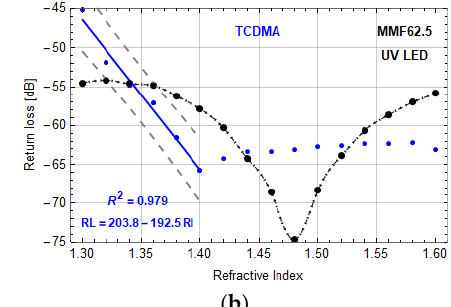
Figure 7. Return loss vs. RI—microtip manufactured by using UV LED on MMF200 based on polymer: ( a ) PETA—microtip size: 200 ± 1 µm base diameter, ( b ) TCDMA—microtip size: 196 ± 1 µm base diameter. Manufacturing parameters: optical power—500 μW and exposition time—30 s. Red and blue lines are linear approximations of measurement points with presented equations and coefficient of determination R 2 . Black dots are reference measurements of the return loss of MMF200 without microtip.